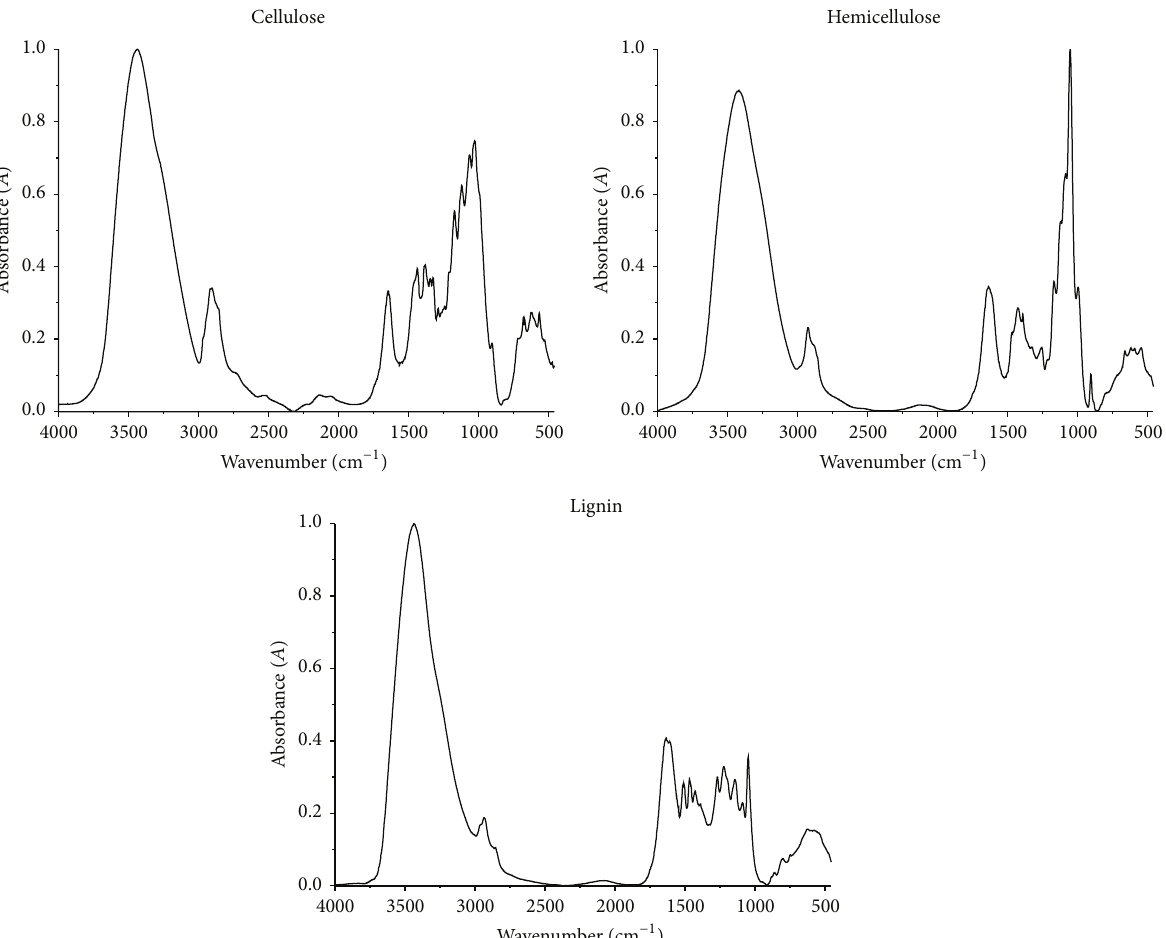
hand, hemicelluloses has a chemical composition which strongly depends on the type of biomass, being constituted by a linear chain of 𝛽 -( 1 → 4 ) sugar units and various types of branched sugar units bonded in different ways to the linear skeleton. Hemicellulose composition of giant reed closely resembles that of the hardwoods species, showing the prevailing of xylan polysaccharides (xylose represents about 90% of total monosaccharides content) over other noncel- lulosic sugars, such as arabinose, galactose, and mannose, which account for the remaining 10% of total monosac- charides content [36]. Therefore, the choice of a birchwood hemicellulose as reference compound for the development of ternary mixture method seemed appropriate. Finally, lignin is a very complex polymer of phenyl propane units, which are connected to each other by means of different types of